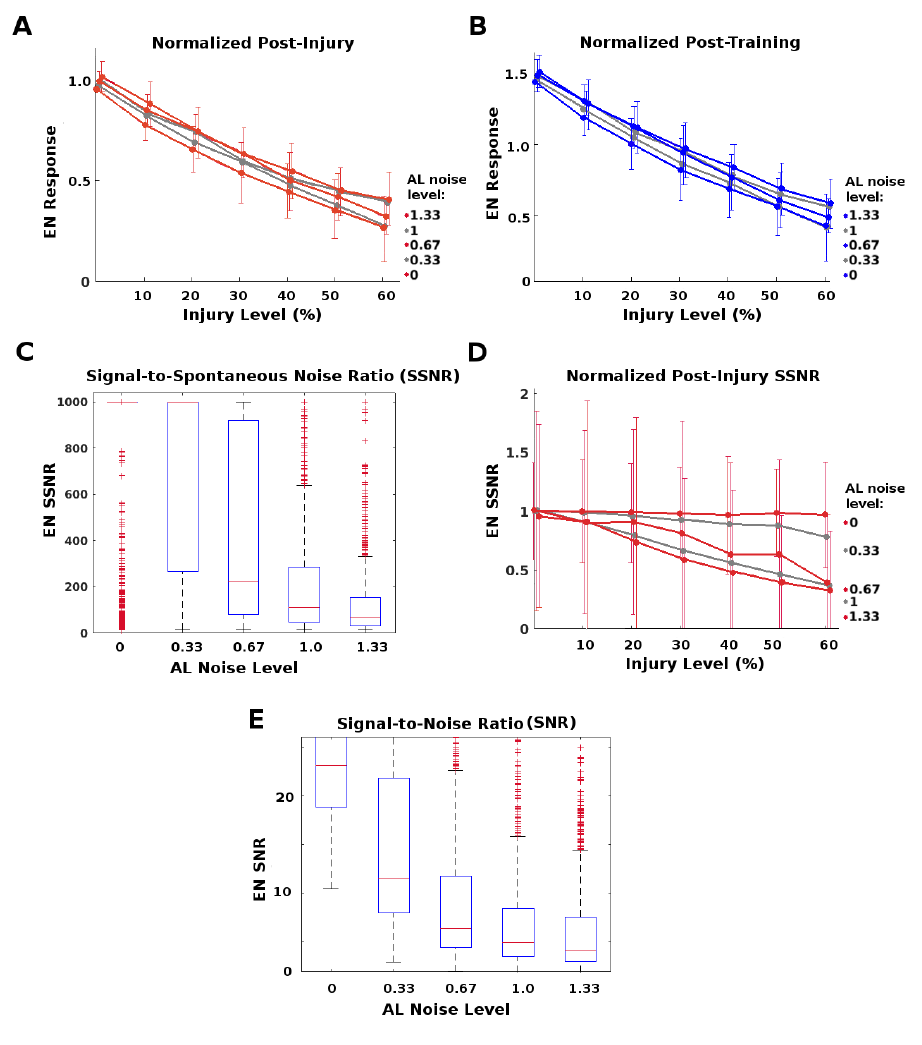
Figure 6. Protective effects of AL noise on the strongest (top-tranche) EN responses: Given RN injury, AL noise protected the strongest EN responses from loss ( A , B ), but exacted a cost in terms of signal-to-spontaneous noise ratio (SSNR) and signal-to-noise ratio (SNR) ( C–E ). ( A ): Post-injury EN responses of the top 15% tranche (i.e., the strongest odor responses), normalized by their pre-injury response, vs. injury level. Higher AL noise reduced attenuation from injury, at any level of injury. Each curve corresponds to a level of AL noise, from 0 to 1.33 where 1 = “natural” level. Pre-injury response = black line. ( B ): Post-injury EN responses of the top 15% tranche, normalized by their pre-injury response, vs. injury level. Higher AL noise allowed training to give full recovery of these top EN responses from larger injuries, ≈ 28% injury given maximum noise vs. ≈ 20% injury given no AL noise. ( C ): Naive healthy ratio of EN SSNR was much lower at high AL noise levels. ( D ): Post-injury SSNR, normalized by pre-injury ratios, vs. injury level. Injury lowered SSNR far more in moths with high AL noise. ( E ): Naive healthy SNR was much lower in moths with high AL